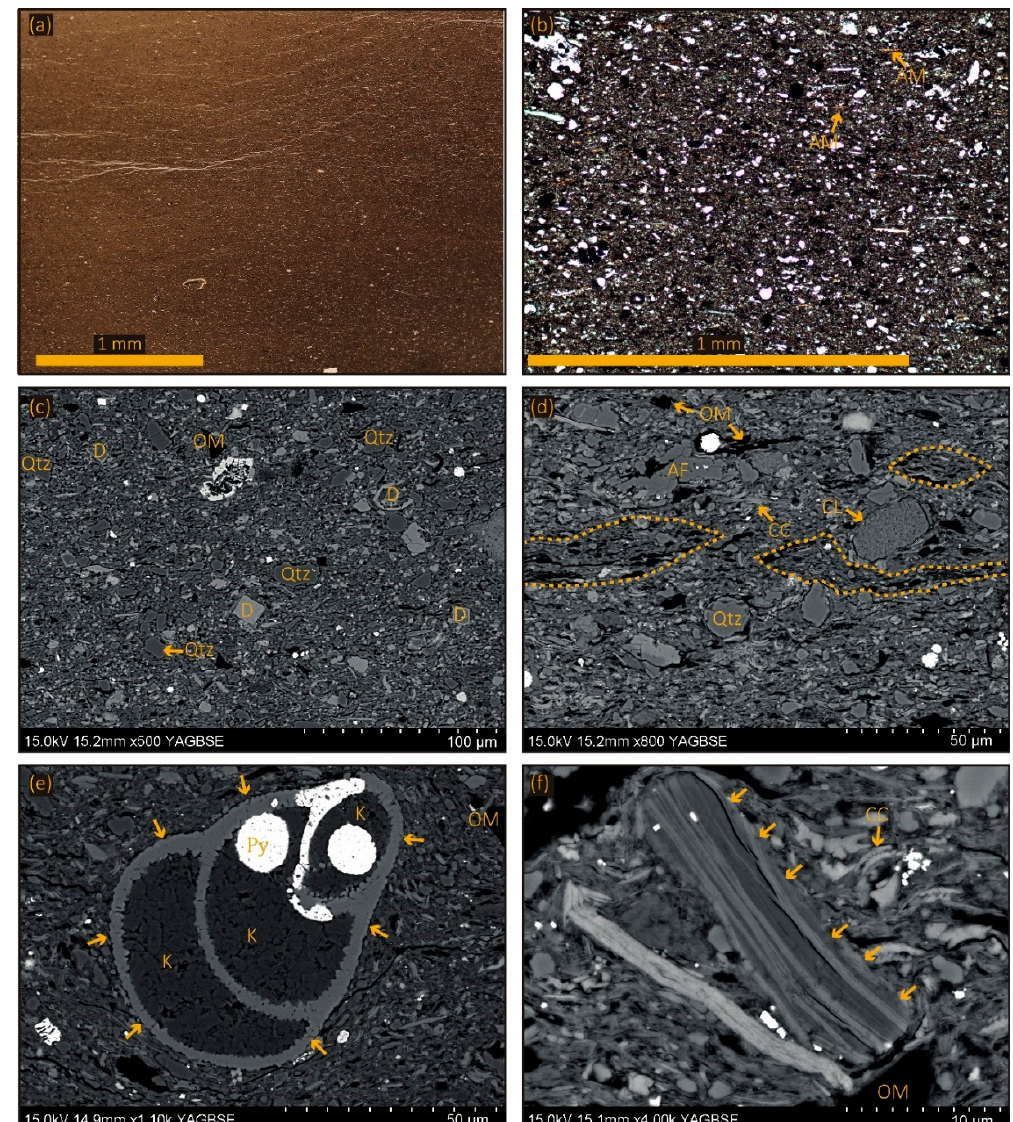
Figure 3. Facies 1: Clastic-detritus-rich medium-grained mudstone. ( a ) Low power optical photomicrograph of EB 33.17 m showing the homogenous nature of the facies. ( b ) Optical micrograph of sample EB 33.17 m showing homogeneous nature of the sample. Note the presence of algal macerals (AM) and the argillaceous matrix. ( c ) Backscattered electron photomicrograph of sample EB 57.70 m. Note the dolomite rhombs (D) and equant organic material (OM). ( d ) Backscattered electron photomicrograph of sample EB 64.50 m. Yellow dashed lines mark the boundary of organo-minerallic aggregates. Note the presence of single collapsed agglutinated foraminifera (AF), clay mineral grain (CL) and coccolith debris (CC) in the matrix. ( e ) Backscattered electron photomicrograph of sample EB 35.17 m showing a multi-chambered foraminifera (yellow arrows) infilled with authigenic kaolinite (K). Note the presence of pyrite (high η ) as framboids and as a replacement mineral in the foraminifera test. ( f ) Backscattered electron photomicrograph of sample EB 35.17 m showing a chlorite grain (indicated by the yellow arrows).